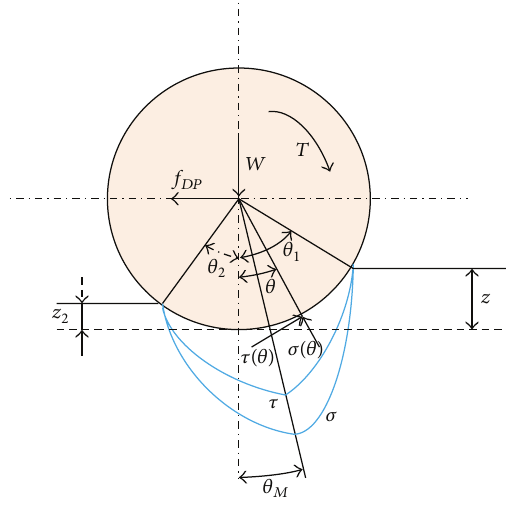
Figure 2: Wheel-soil interaction mechanics